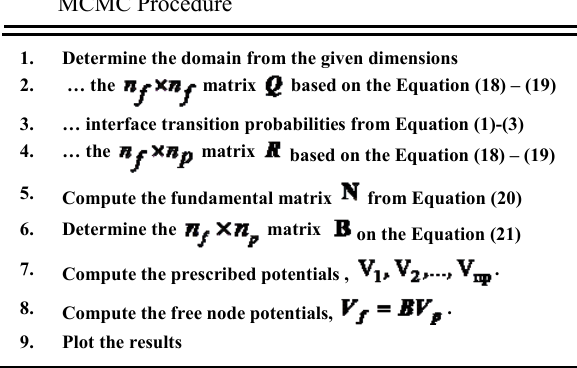
Table 2: Results Comparison between FDM and MCMC for Axisymmetric Inhomogeneous Problem with Constant Boundary Potential.